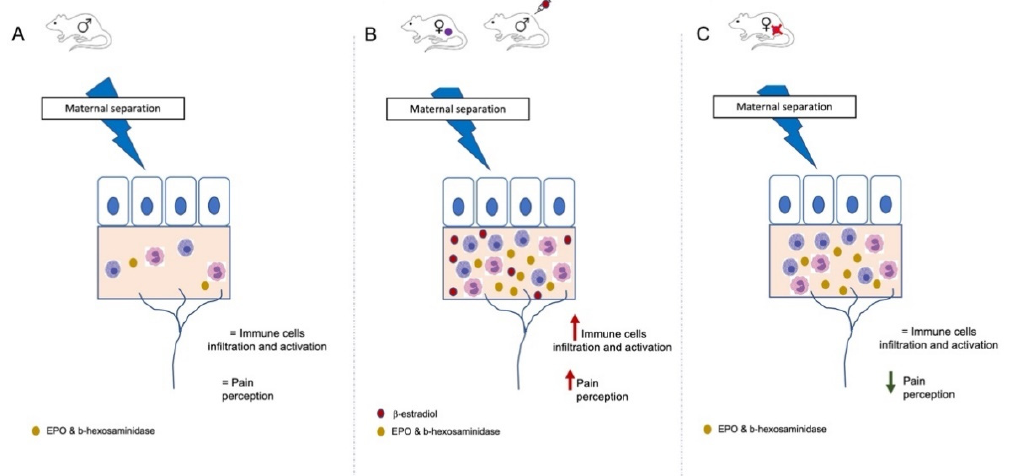
Figure 8. Summary of results for both sexes under stress conditions. In the BBDP-N rat, an animal prone to develop DGBI, early-life stress did not change either the immune cell infiltration and activation in the GI tract or colonic hypersensitivity in males ( A ). In females and males injected with β -estradiol, an increase in immune cells infiltration and activation in the GI tract was associated with an increased colonic sensitivity ( B ). In ovariectomized females, the immune cell infiltration and activation did not change, while the perception of colonic distention was reduced ( C ).